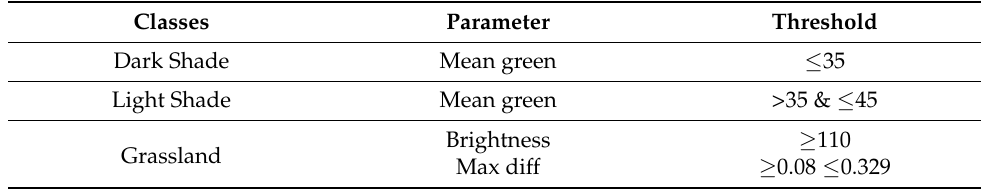
Table 1. Decision-rules for classification of noise.